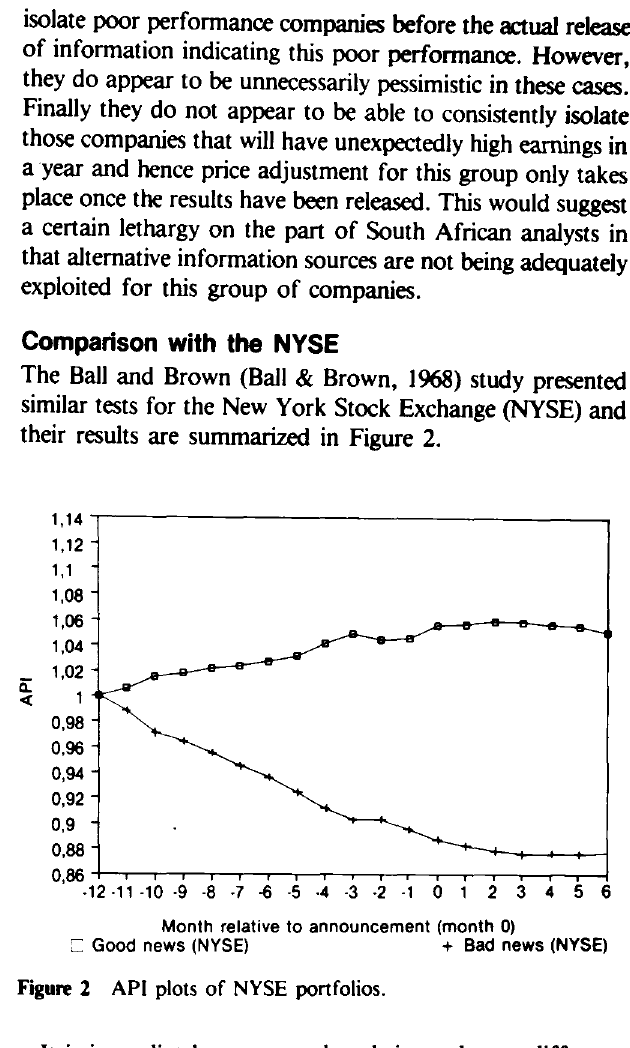
Figure 2 API plots of NYSE